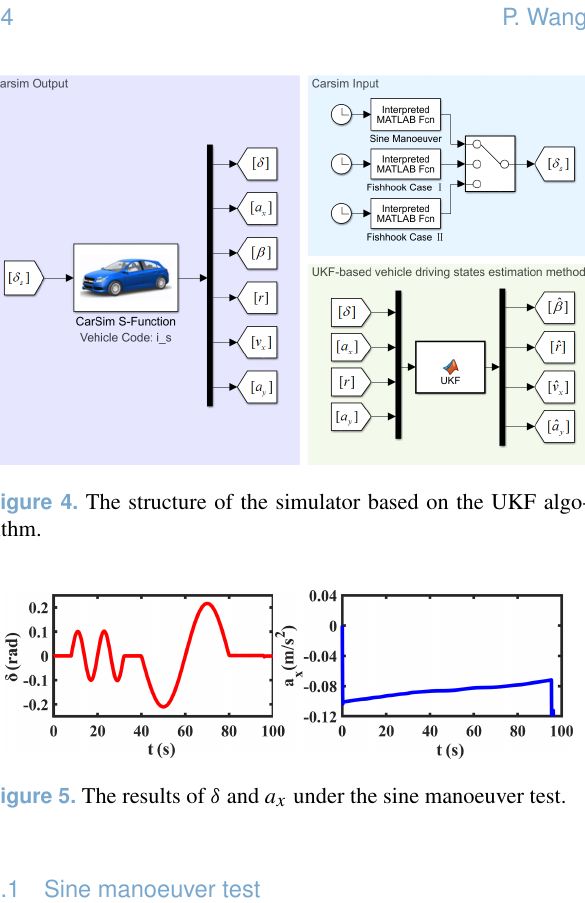
Figure 7. The absolute error curves of β , r , v x , and a y under the sine manoeuver